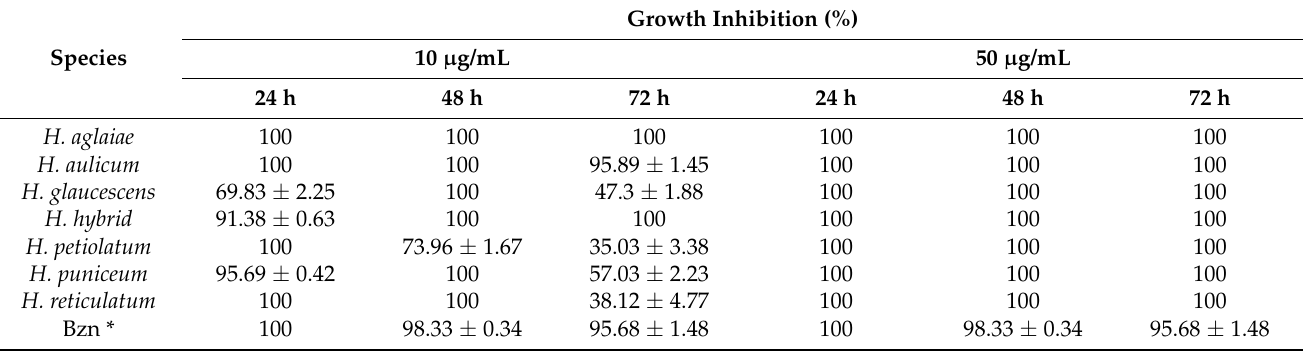
Table 3. In vitro activity of Hippeastrum spp. BAREs from Argentina on proliferation of T. cruzi epimastigotes (mean ±